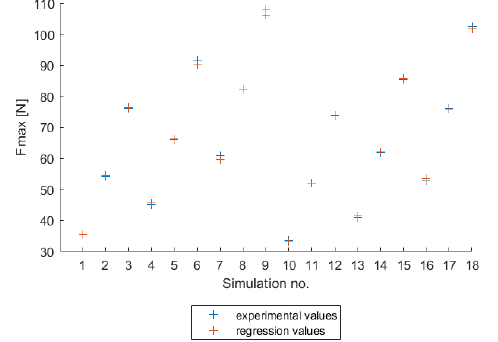
Figure 13. F max : Comparison experimental values and regression values